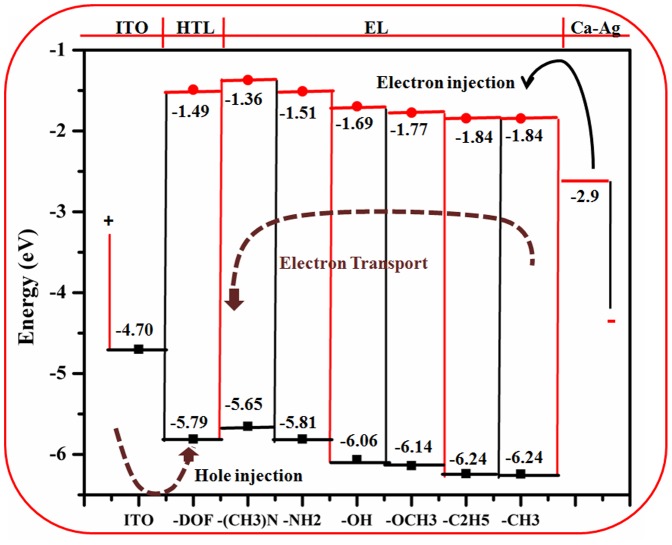
Schematic diagram of a two-layered OLED device.